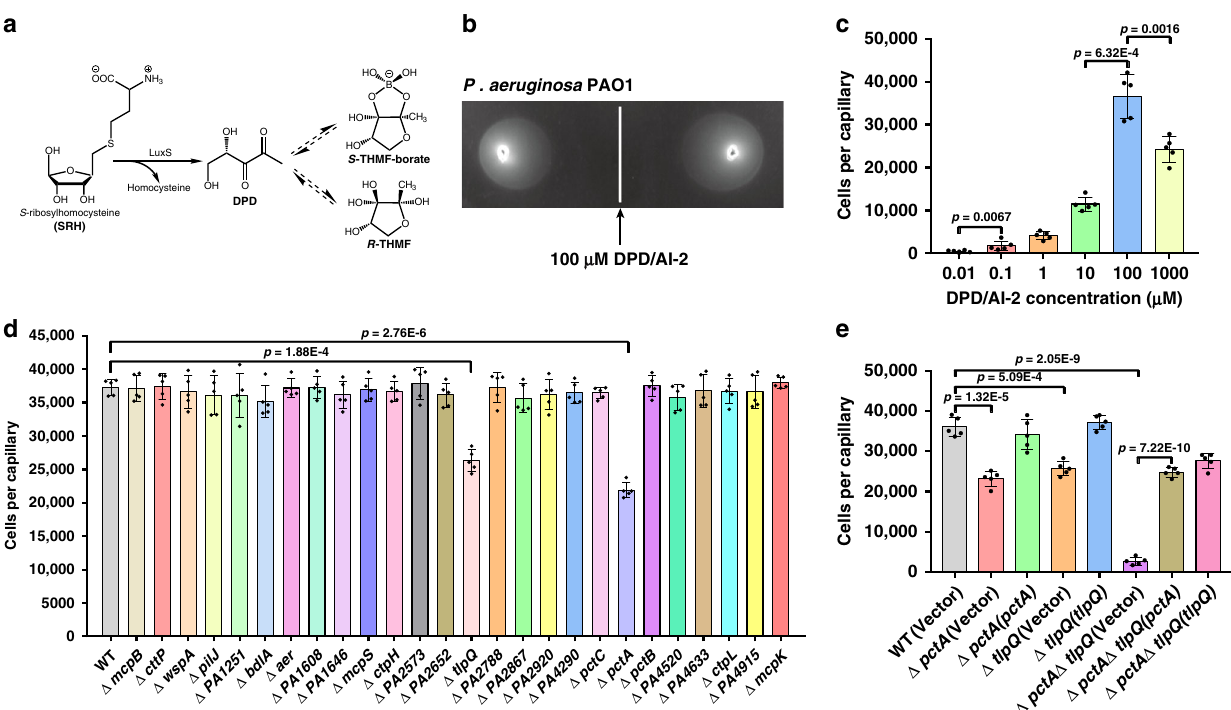
Fig. 1 Chemotaxis of P. aeruginosa PAO1 to AI-2 requires the chemoreceptors PctA and TlpQ. a A diagram of AI-2 biosynthesis by LuxS 6,7 . The borated AI-2 signal S -THMF-borate is recognized by the receptor LuxP in Vibrio spp .6 , whereas the nonborated R -THMF binds to the receptor LsrB found in enteric bacteria and some other microorganisms belonging to the Rhizobiaceae , Bacillaceae and Clostridiaceae families 7 – 13 . b Plate gradient chemotaxis of P. aeruginosa . 10 μ l aliquots of DPD/AI-2 (100 μ M) were spotted onto M9 plates containing 2.5 mM glucose and 0.25% (w/v) Bacto agar and 2 μ l aliquots of P. aeruginosa cultures with an OD 600 of 0.6 in M9 medium were placed at 2 cm distance from the DPD/AI-2 spots. The distance from the site of inoculation to the colony edges closest to (D1) and furthest from (D2) the DPD/AI-2 spot was measured and the response index (RI) was calculated as follows: RI = D1/(D1 + D2). Data shown are one representative of fi ve independent experiments with similar results (RI values are presented as mean ± s.d.; n = 5 independent experiments). c Quantitative capillary chemotaxis induced by AI-2. 230 μ l aliquots of P. aeruginosa PAO1 with an OD 600 of 0.1 in chemotaxis buffer were placed into the wells of a 96-well plate and capillaries fi lled with chemotaxis buffer or different concentrations of DPD/AI-2 solutions (0.01- 1000 μ M) were immersed into bacterial suspensions for 30 min. Serial dilutions of the contents from the capillaries were plated on LB agar plates and the CFU were determined. Cell numbers were corrected by subtracting the number of cells that have swum into the buffer-containing capillaries. d Optimal response to AI-2 requires PctA or TlpQ. Chemotactic responses of the wild-type (WT) PAO1 and 26 mutants to 100 μ M DPD/AI-2 were measured by the quantitative capillary chemotaxis assay as described in ( c ). e PctA and TlpQ are required for chemotaxis induced by AI-2. The indicated strains were measured for quantitative capillary chemotaxis as described in ( c ). Complementation genes were expressed from derivatives of pME6032. c – e Statistical analyses were carried out by results from fi ve independent experiments, each experiment having three technical replicates. Similar results were obtained in fi ve independent experiments and data are presented as mean ± s.e.m. Two-sided, unpaired Student ’ s t -test was used for these analyses, and p values < 0.05 were considered to indicate statistically signi fi cant